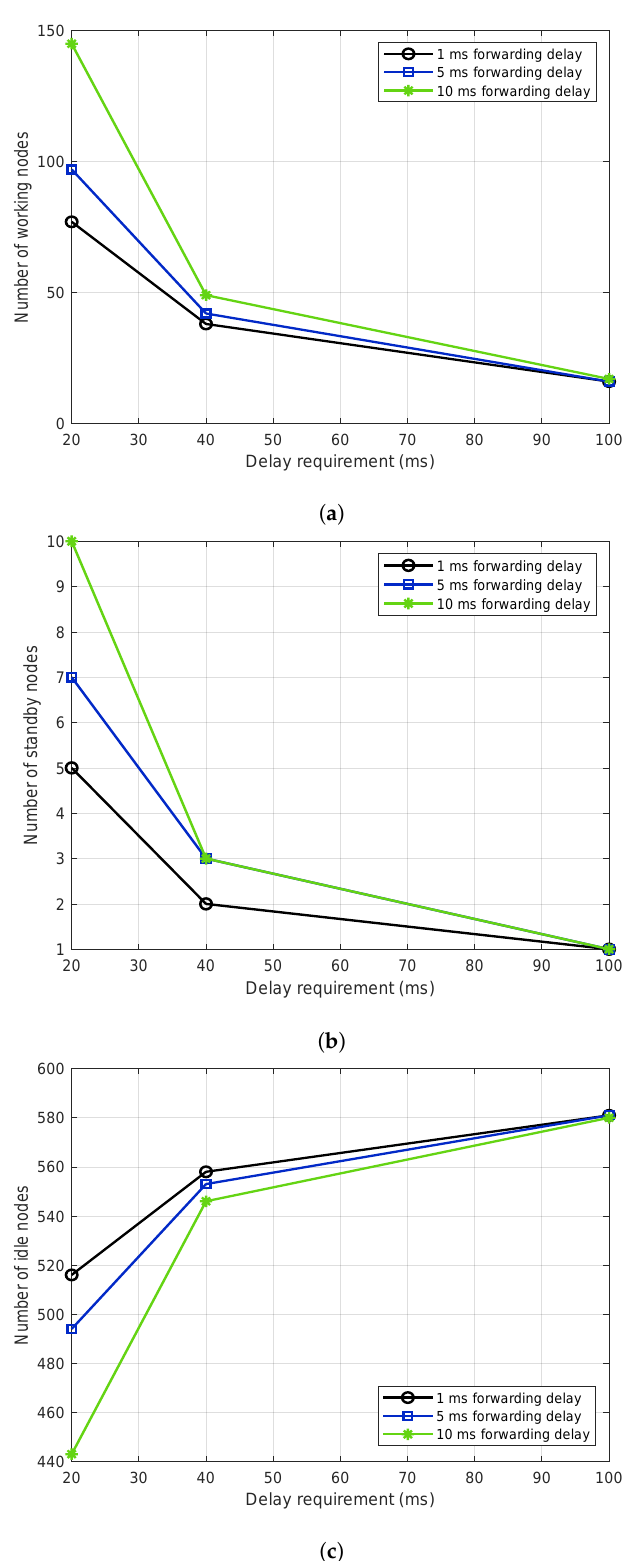
Figure 8. The influence of D forward on the number of selected WFNs, SFNs and IFNs under different delay requirements in GDAFC. ( a ) The number of WFNs under different imposed delay requirements; ( b ) the number of SFNs under different imposed delay requirements; ( c ) the number of IFNs under different imposed delay